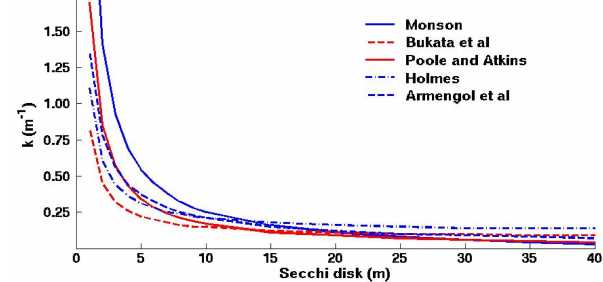
Figure 7. A comparison of five methods relating light extinction co- efficients to Secchi disk depths, showing that all methods compare reasonably well at Secchi disk depths >